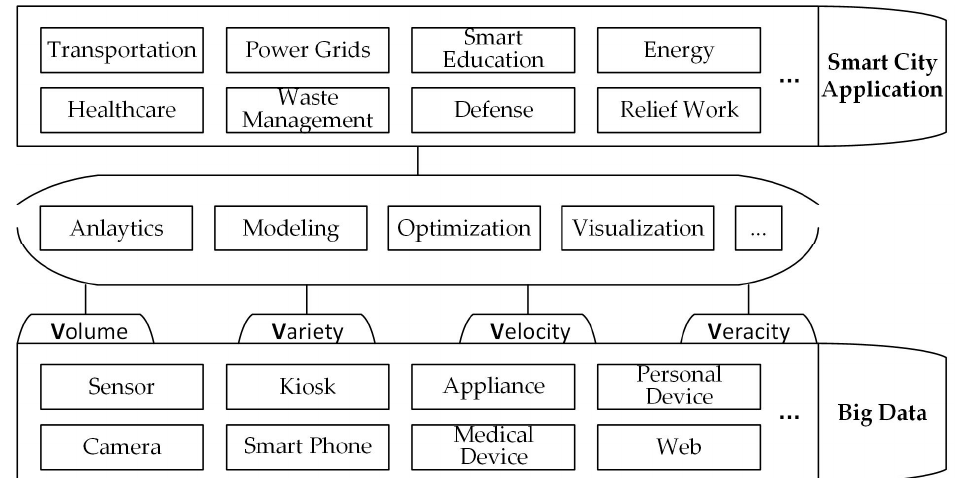
Figure 1. Big Data for Smart City Application.